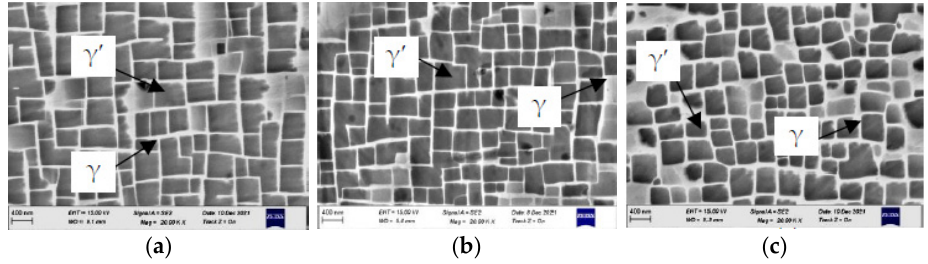
Figure 3. The microstructures of the alloy with different Co content after full heat treatment: ( a ) 6% Co; ( b ) 9% Co and ( c ) 12% Co.